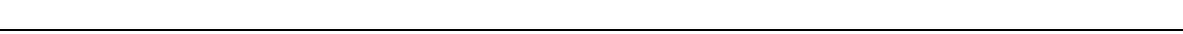
Fig. 4 miR-9a – targeted adenylyl cyclase 2 ( ac2 ) mediates locust preference for gregarious volatiles. a Functional cluster of miR-9a target genes using GO enrichment analysis. b mRNA level of genes in the clusters ( P < 0.01) as validated by qPCR ( n = 8, Student ’ s t -test). c Luciferase reporter assays in S2 cells co-transfected with miR-9a overexpression vectors and psiCHECK2 vectors containing binding sites of the target genes ( n = 6, Student ’ s t -test). d Luciferase reporter assays in S2 cells co-transfected with miR-9a overexpression vectors and psiCHECK2 vectors containing wild (WT) or mutant (MT) sequences of target genes ( n = 6, Student ’ s t -test). e Olfactory responses of the solitarious and gregarious locusts injected with dsPhf20l1 ( n = 46 and 43) and dsAc2 ( n = 40 and 46), respectively. f Olfactory responses of the solitarious and gregarious locusts injected with AC2 agonist (forskolin, n = 44 and 45) and antagonist (SKF83566, n = 48 and 41), respectively. The data in b , c , and d are shown as mean ± SEM, and the data in e and f are shown as p ± SE. The asterisks outside the strip indicate the signi fi cant difference between controls and the treatments by G -test for independence ( e and f ); n.s.: not signi fi cant; * P < 0.05; ** P < 0.01; S: solitarious, G: